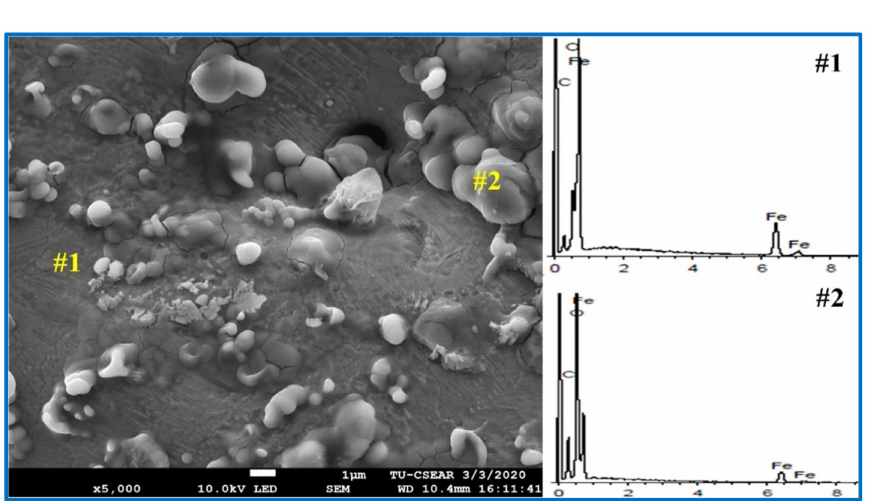
Figure 10. SEM micrograph ( × 5000) on the surface of the metallic Fe droplets obtained after high- temperature interaction of the CCP for 30 min in the case of coal.